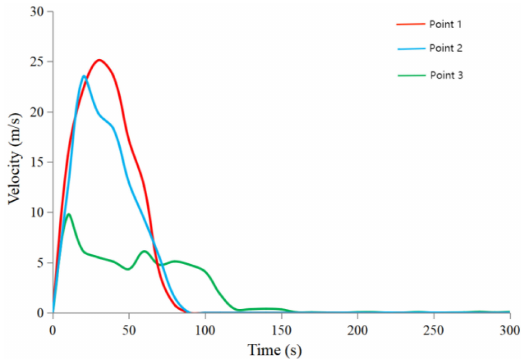
Figure 17. Velocity–time curves of tail sand movement at different measurement